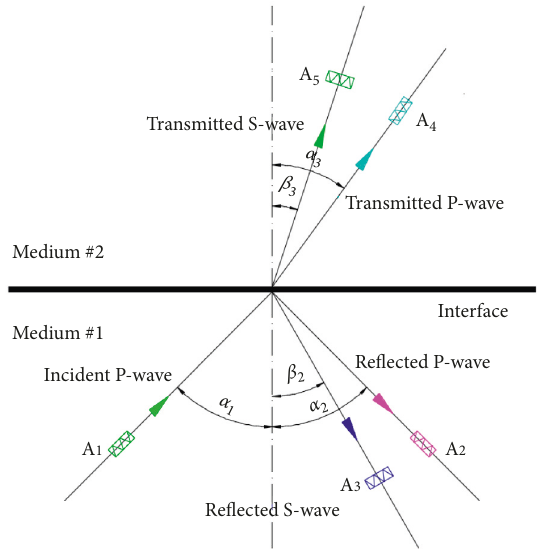
Figure 1: Oblique incidence of stress